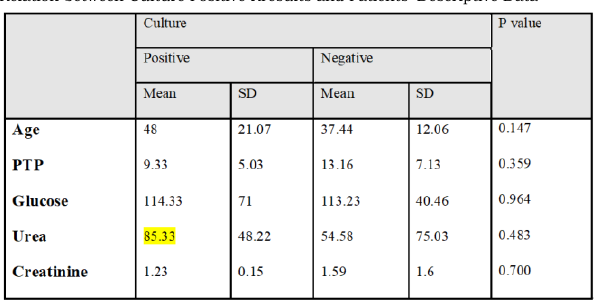
Table 1 Relation between Culture Positive Rresults and Patients’ Descriptive Data